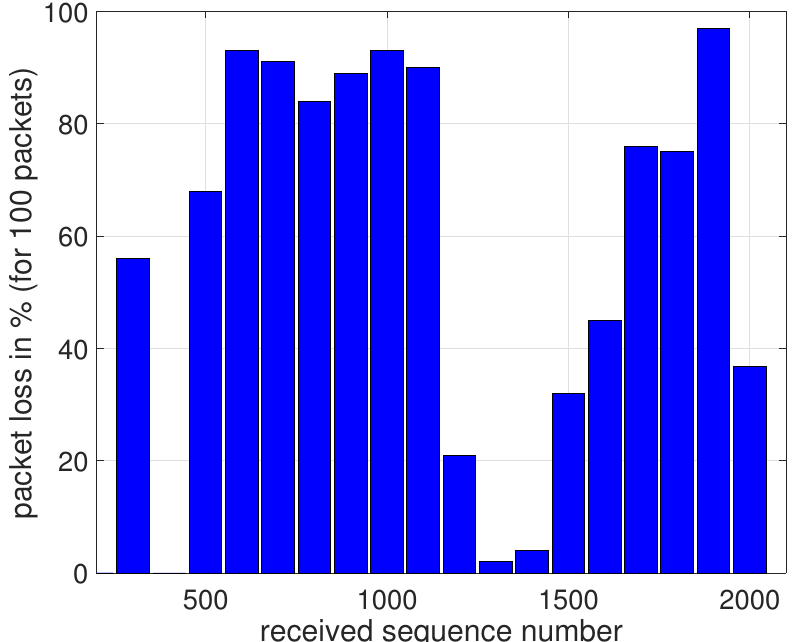
Figure 12. Packet loss observed at two positions separated by 500 m. Table 2. Packet loss under LoS